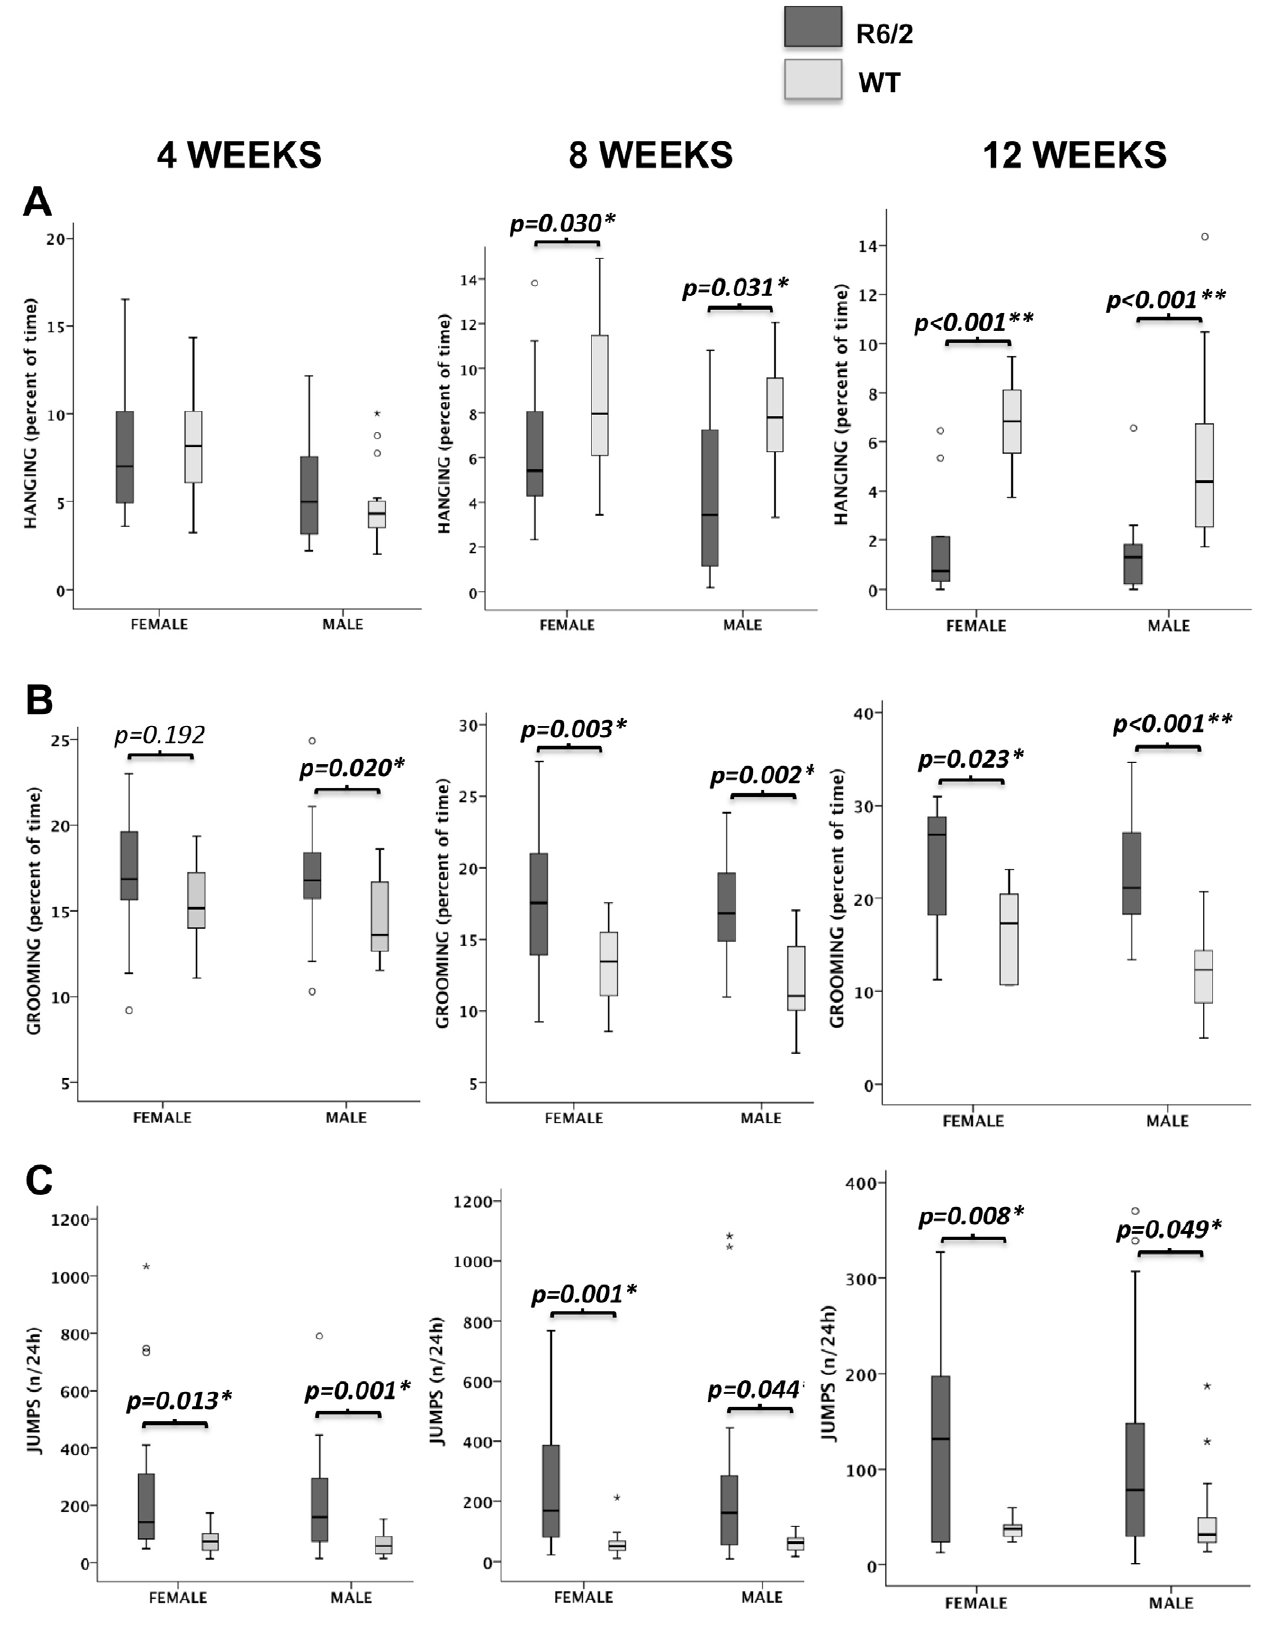
Figure 1. HomeCageScan behaviours in R6/2 mice at age 4, 8 and 12 weeks. (A) Total time spent hanging, (B) grooming and (C) number of jumps, from the HomeCage recording. n=20 animals/group.